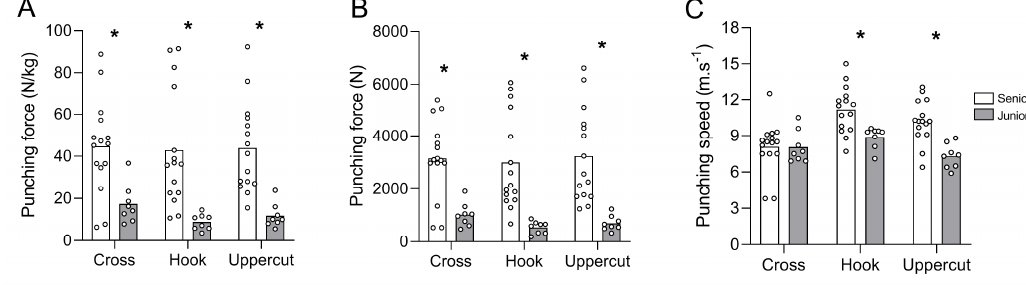
Figure 1. ( A ), punching force (N/kg), ( B ), punching force (N), ( C ), punching speed (m·s − 1 ) for the different punching techniques for the two groups of boxers. Bars represent mean values while white points represent individual data points. * denotes a significant difference between groups ( p ≤ 0.05).